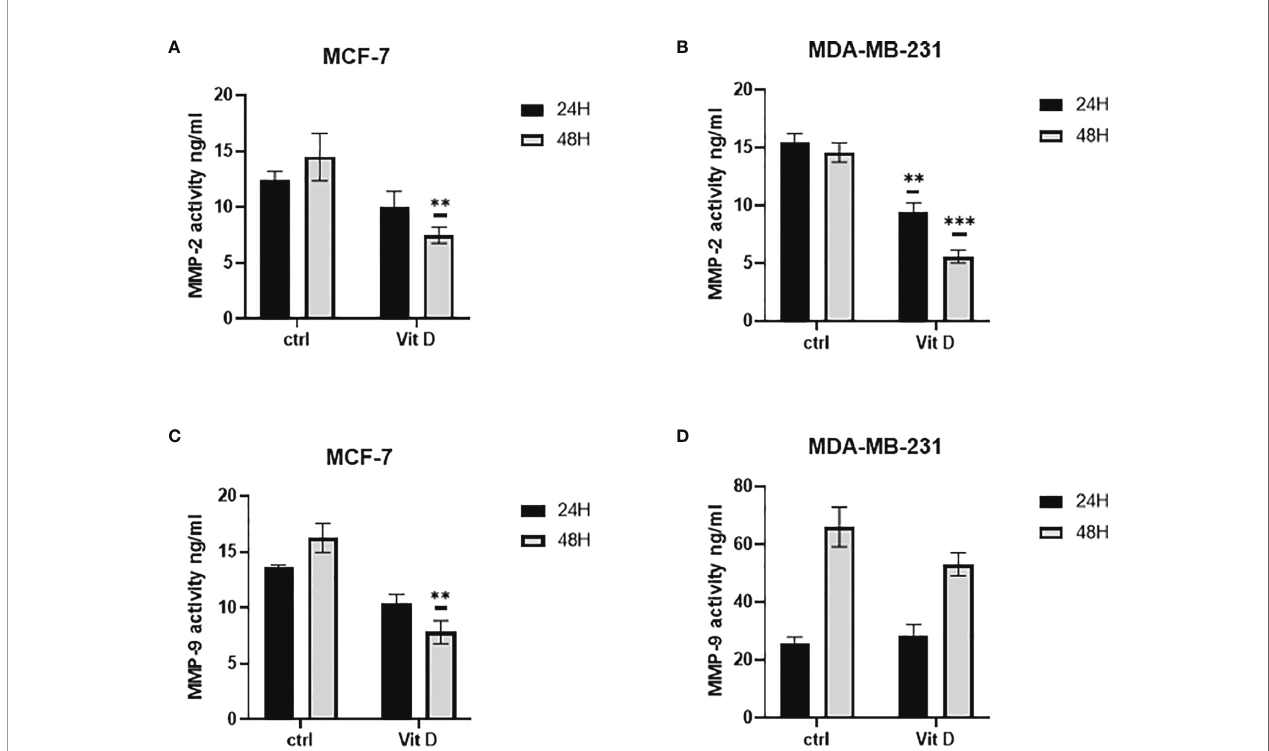
FIGURE 3 | Quantitative analysis using ELISA to measure MMP-2 and MMP-9 activities. Enzymatic activity was measured using ELISA in MCF-7 (A, C) and MDA- MB-231 (B, D) cells following 10 µM of calcitriol treatment. (** and ***) represents statistically signi fi cant change (p < 0.05 and p < 0.001) in MMP-2 and MMP-9 enzymatic activity between treated and control (Ctrl) untreated cells at given time